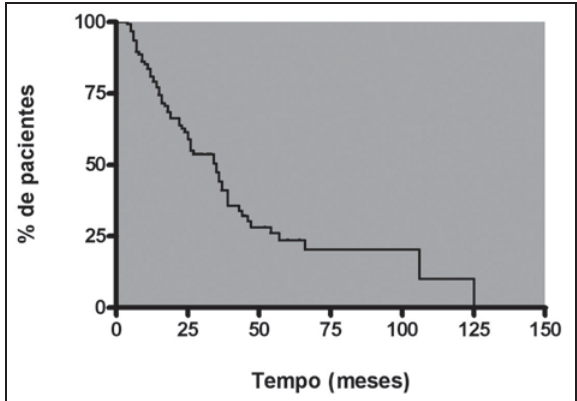
Figura 3 – Sobrevida global dos pacientes